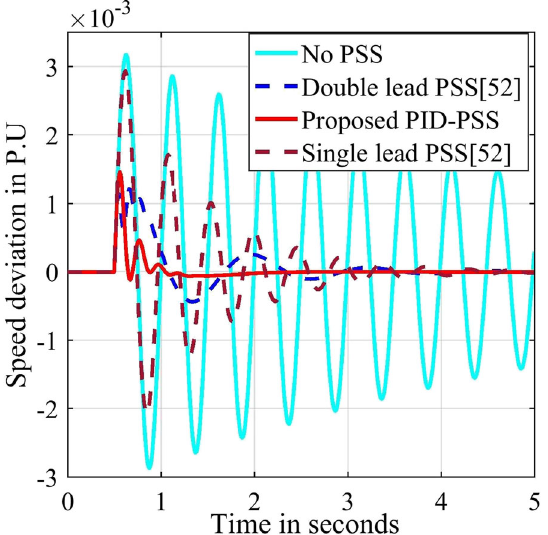
Fig. 21 Comparison of heavy load ( P = 1 p.u. and Q = 0.875 p.u. ) response of Barka-II Power station of the proposed with existing methods to 0.1 p.u. torque